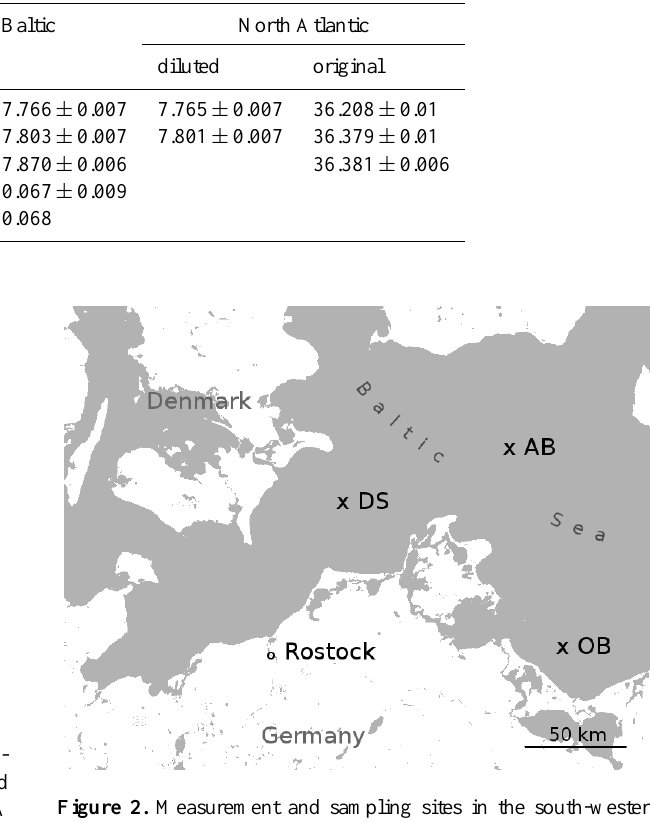
Figure 2. Measurement and sampling sites in the south-western Baltic Sea. DS = Darß Sill, AB = Arkona Basin, OB = Oder